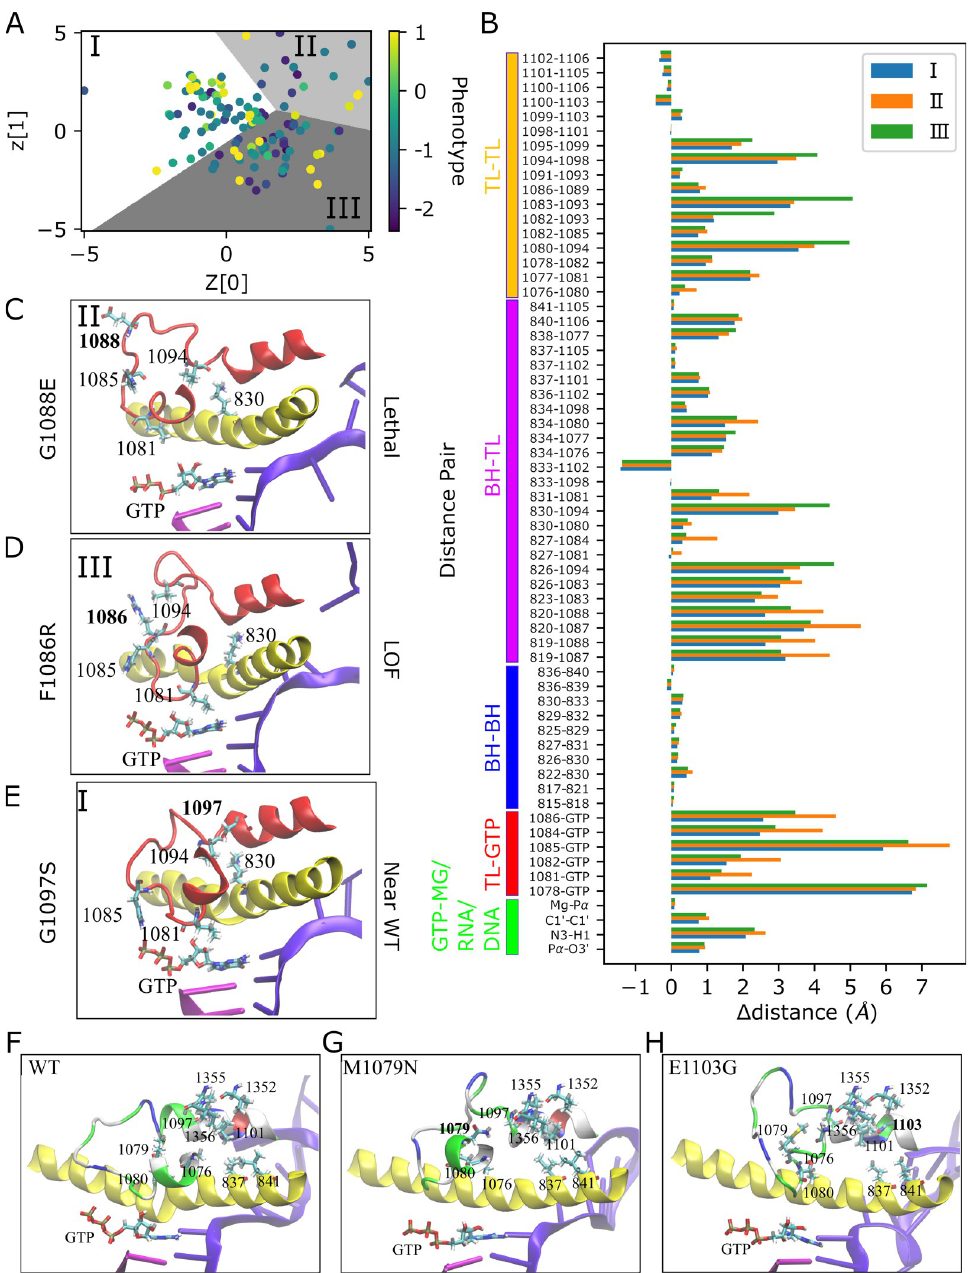
Fig 6. VAE analysis of MD distance data. (A) Latent space from VAE model based on MD distance data shaded according to clusters (I is white, II is gray, III is dark gray) and with each point colored to the mutant phenotype. The axes z[0] and z[1] are the first and second dimensions of the 2D latent space generated by projecting the MD data using the VAE model. (B) Distance difference graph; Δ distance shows the differences of the distances from the generative model of VAE at the cluster centers from the WT structure after the equilibration. Panels (C), (D) and (E) show the active site neighborhoods for representative mutants for each cluster in final MD snapshots with the TL (red), BH (yellow), DNA (violet), RNA (magenta) and GTP. Atoms are colored by atom name for residues shown in licorice representation. Panels (F), (G) and (H) show the residues forming hydrophobic pocket for the WT after equilibration and GOF mutants at their final MD snapshots. Color codes are the same as described above except that the TL is shown with residues colored by residue type where positively charged amino acids are in blue, negatively charged ones are in red, polar ones are in green, and hydrophobic ones are in